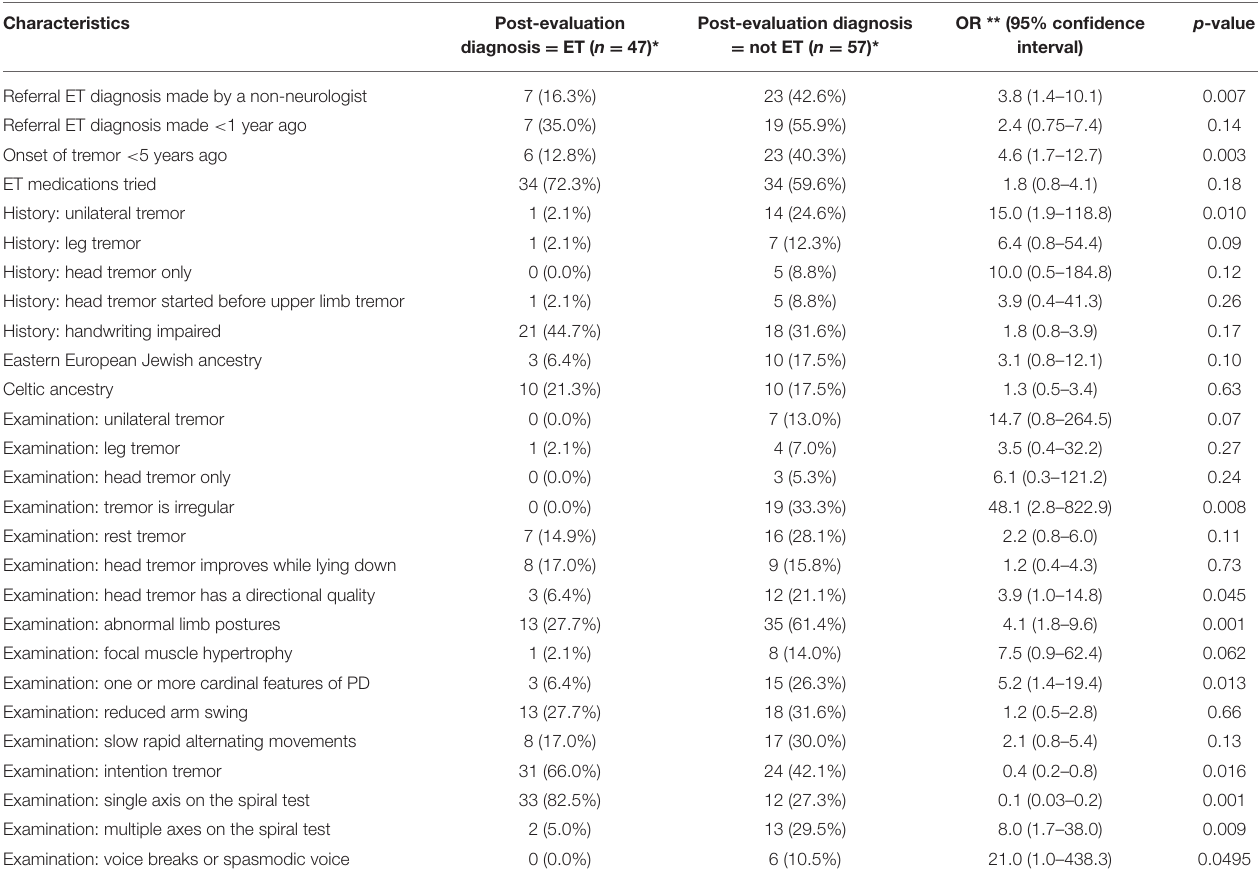
TABLE 3 | Additional clinical characteristics of 47 patients with a post-evaluation diagnosis of ET versus 57 patients with all other post-evaluation diagnoses.